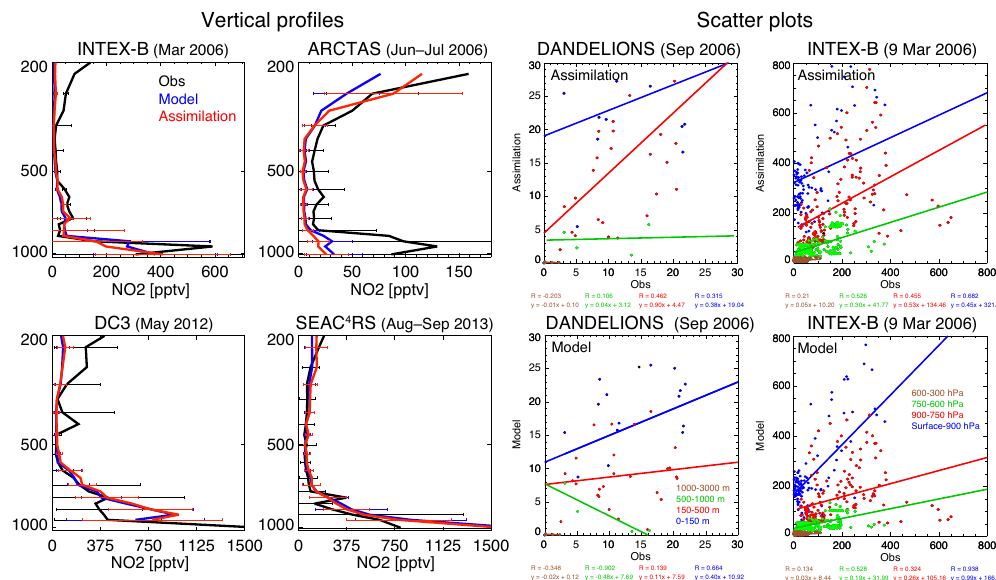
Figure 4. Left panels: mean vertical NO 2 profiles obtained during the ARCTAS campaign in June–July 2009, the ARCTAS campaign in June–July 2006; the DC3 campaign in May 2012, and the SEAC 4 RS campaign in August–September 2013. The black line represents the observation, the blue line represents the model simulation, and the red line represents the data assimilation. The error bars represent the standard deviation. Right panels: scatter plots of NO 2 concentrations for the data assimilation (top panels) and the model simulation (bottom panels) during the DANDELIONS campaign (µgm − 3 ) in September 2006 and during the INTEX-B campaign (in pptv) on 9 March 2006. The straight lines represent linear regression lines for each level. Each line represents a linear fit to the points of the same colour, and the colours represent the altitude